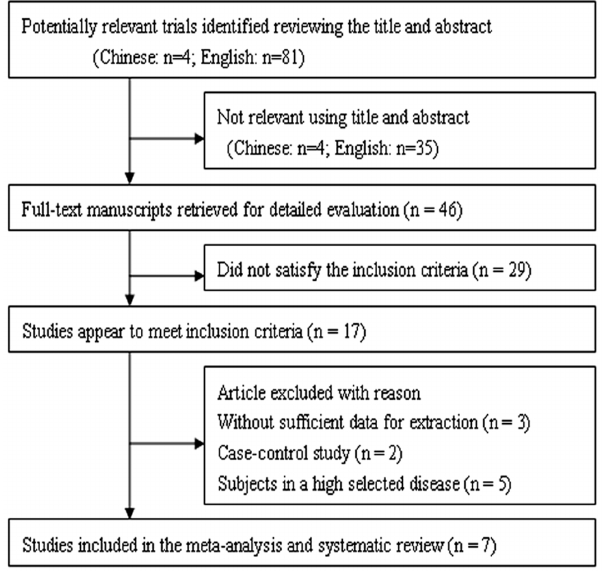
Figure 1. Flow chart of study selection process for meta-